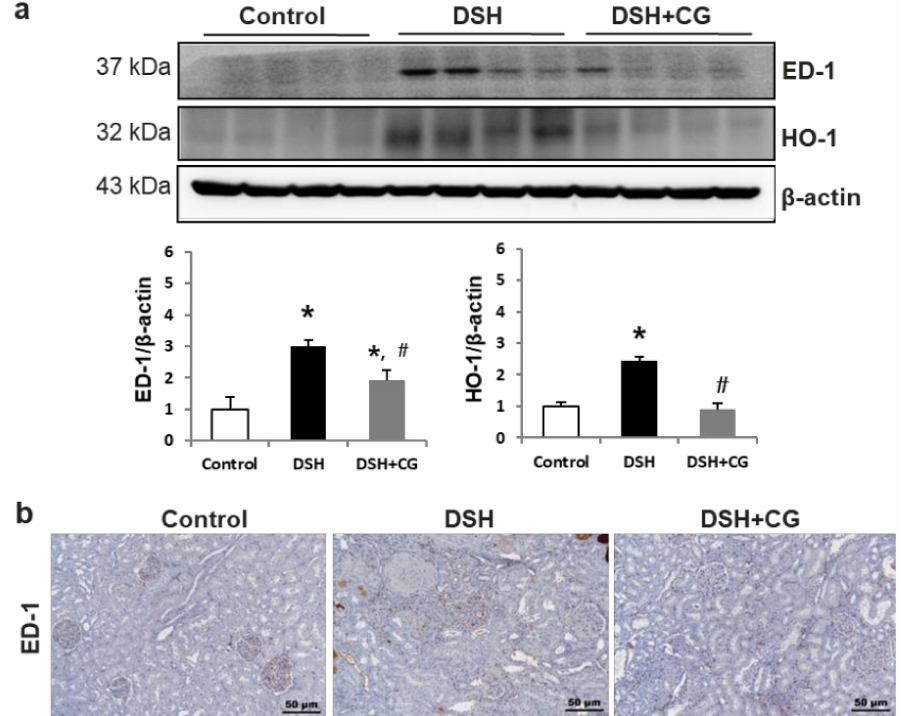
Figure 6. CG200745 suppresses inflammatory markers in deoxycorticosterone acetate (DOCA)-salt hypertensive (DSH) rats. ( a ) Semiquantitative immunoblotting for ED-1 and HO-1 in the kidney. Densitometric analysis revealed that the protein expression of ED-1 and HO-1 was increased in DSH rats, which was counteracted by CG200745 (DSH + CG); * p < 0.05, when DHS or DSH + CG groups were compared to control group. # p < 0.05, when DSH + CG group was compared to DSH group. ( b ) Immunoperoxidase microscopy of ED-1 in the cortex. Increased immunolabeling was observed in DSH rats, which was reversed by CG200745 treatment. Magnification: 100 ×